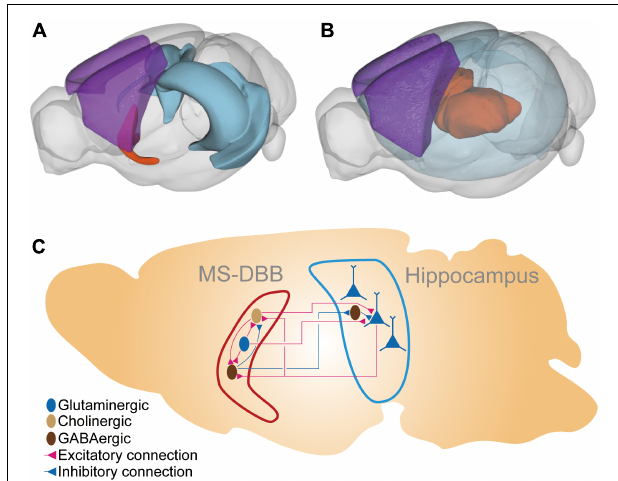
FIGURE 1 | The brain region and the neural connections in the MS-DBB–hippocampus system. (A) The MS-DBB–hippocampus system depicted in 3D space. The blue region is the hippocampal formation; the orange region is the medial septal complex (including MS-DBB). The purple region is the somatomotor areas in the neocortex (isocortex) presented for visual aid to highlight the deep locations of the hippocampus and the medial septal complex. (B) The thalamocortical system depicted in 3D space. The transparent blue region represents the neocortex. The orange region represents thalamus. The purple region is the somatomotor areas in the neocortex presented for visual aid to highlight the deep location of the thalamus. (C) Schematic diagram of the MS-DBB–hippocampus system. The hippocampal pyramidal neurons (blue triangles) are aligned in parallel so that they produce the strong alteration in the electrical field measurable by EEG. The pyramidal neurons receive excitatory cholinergic and glutamatergic inputs from the MS-DBB and inhibitory inputs from hippocampal interneurons. The pyramidal neurons innervate cholinergic and GABAergic neurons in MS-DBB. Dark brown ellipsoids represent GABAergic neurons; light brown ellipsoids represent cholinergic neurons; blue ellipsoids and triangles represent glutaminergic neurons. Red connection and blue connections represent excitatory and inhibitory connections, respectively. The 3D plots were drawn with cocoframer available at a public mouse brain atlas for parts (A) and (B) (Allen Institute for Brain Science,